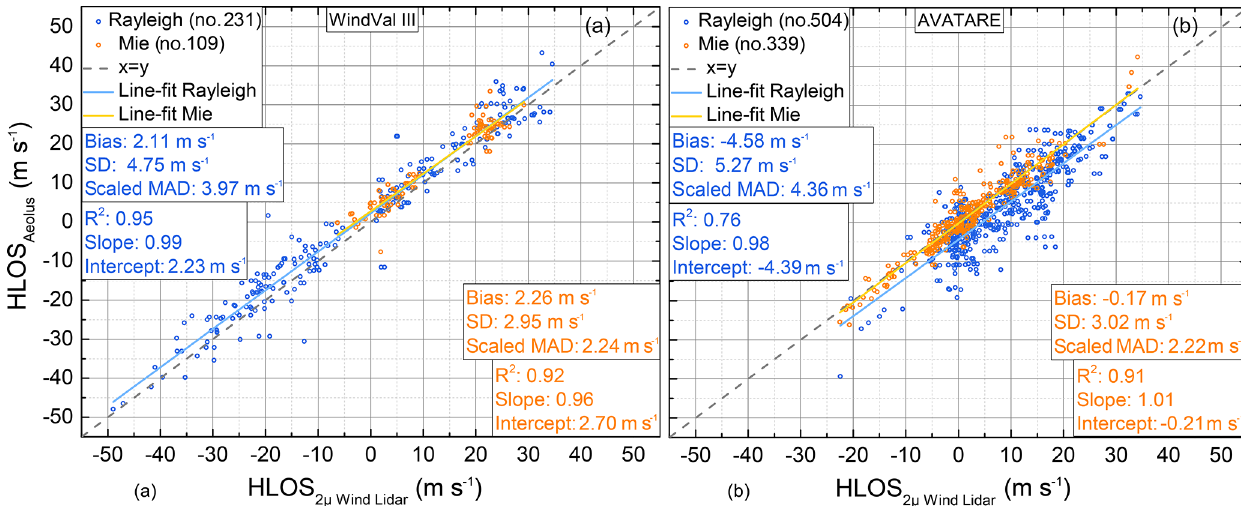
Figure 7. Aeolus HLOS wind speed plotted against the 2µm DWL wind speed projected onto the horizontal viewing direction of Aeolus for eight flight legs from four underflights performed during the WindVal III campaign in 2018 (a) and for 10 flight legs from six under- flights performed during the AVATARE campaign in 2019 (b) (see also Table 1). The wind measurements are separated in Rayleigh-clear winds (blue) and Mie-cloudy winds (orange). Corresponding least-square line fits are indicated by the light blue and yellow lines. The fit results are shown in the insets. The x = y line is represented by the gray dashed